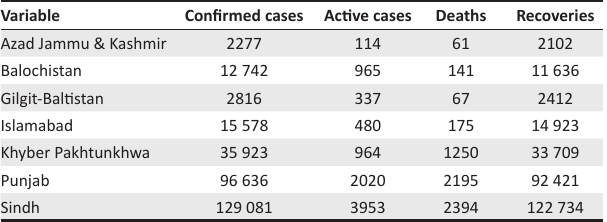
TABLE 2: Province-wise COVID-19 confirmed cases in Pakistan.